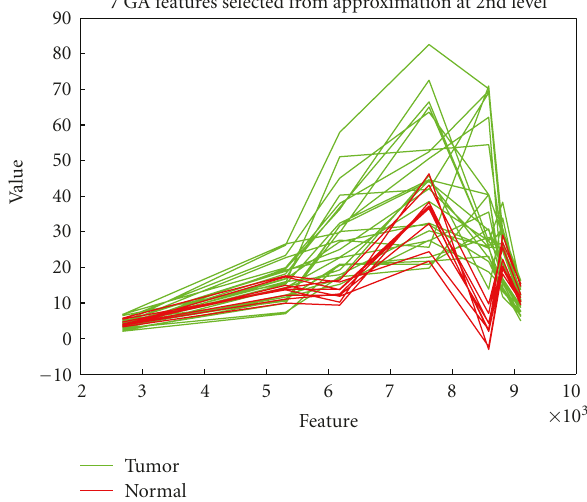
Figure 9: Selected features from reconstructed approximation for test samples of prostate cancer dataset.